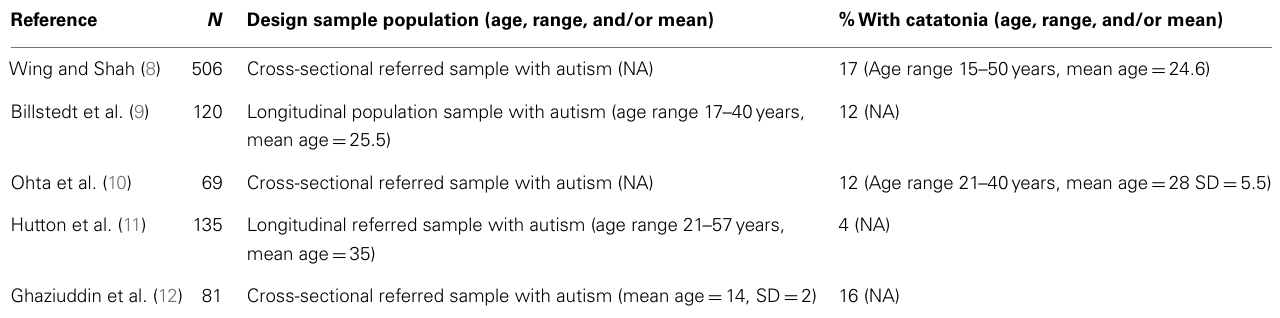
Table 1 | Prevalence studies of catatonia in autism spectrum disorders . Reference N Design sample population (age, range, and/or mean) %With catatonia (age, range, and/or mean) Wing and Shah